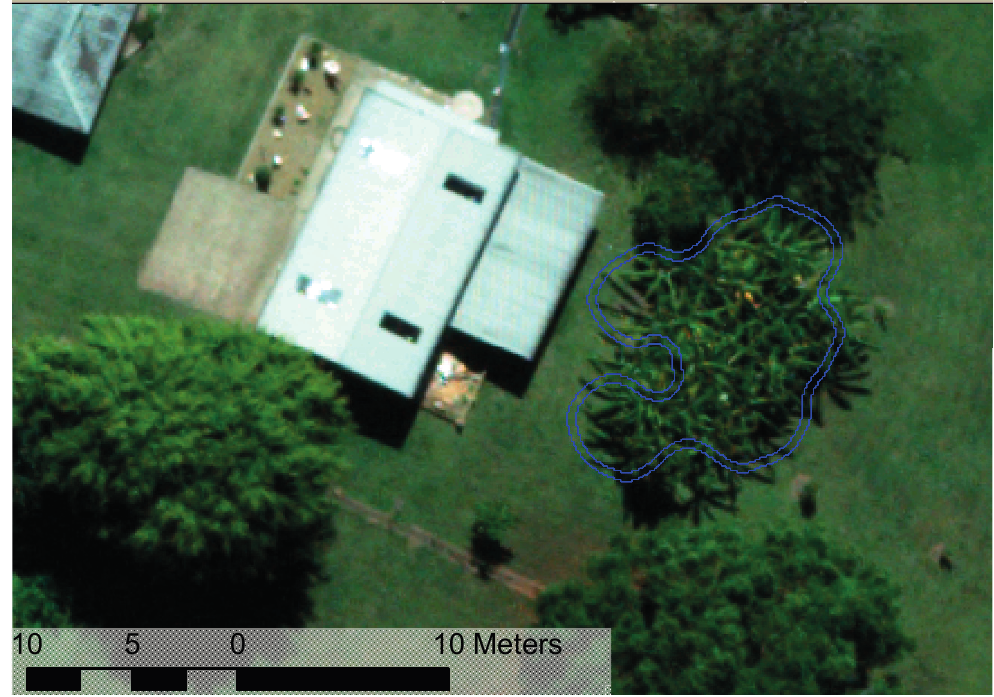
Figure 10. Cluster of banana plants outlined by blue line. Location: 152°59 ′ 00 ″ E, 26°38 ′ 15 ″ S.